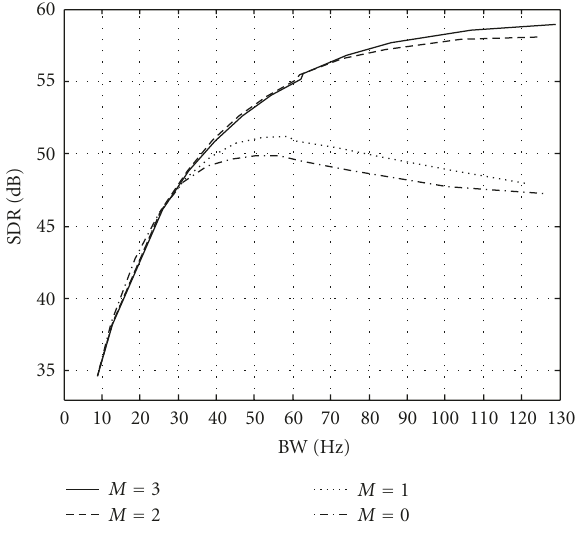
Figure 10: SDR values of the proposed and conventional phase er- ror estimators.